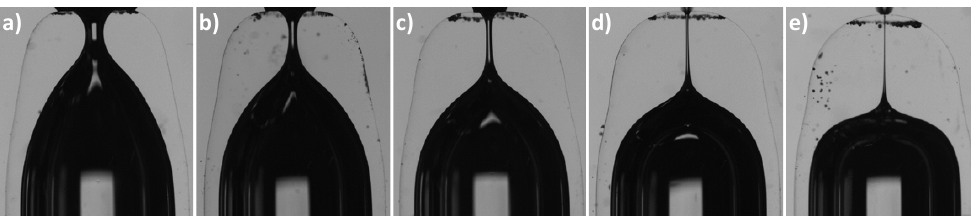
Figure 3. Nozzles manufactured at ( r = 3.5 mm, z = 15 mm) from capillaries type 1: ( a ) t = 75 s, D = 326 ± 4 µ m; ( b ) t = 120 s, D = 156 ± 1 µ m; ( c ) t = 180 s, D = 102 ± 3 µ m; ( d ) t = 300 s, D = 45 ± 2 µ m; ( e ) t = 600 s, D < 10 µ m (not measurable due to limitations of the characterization setup).